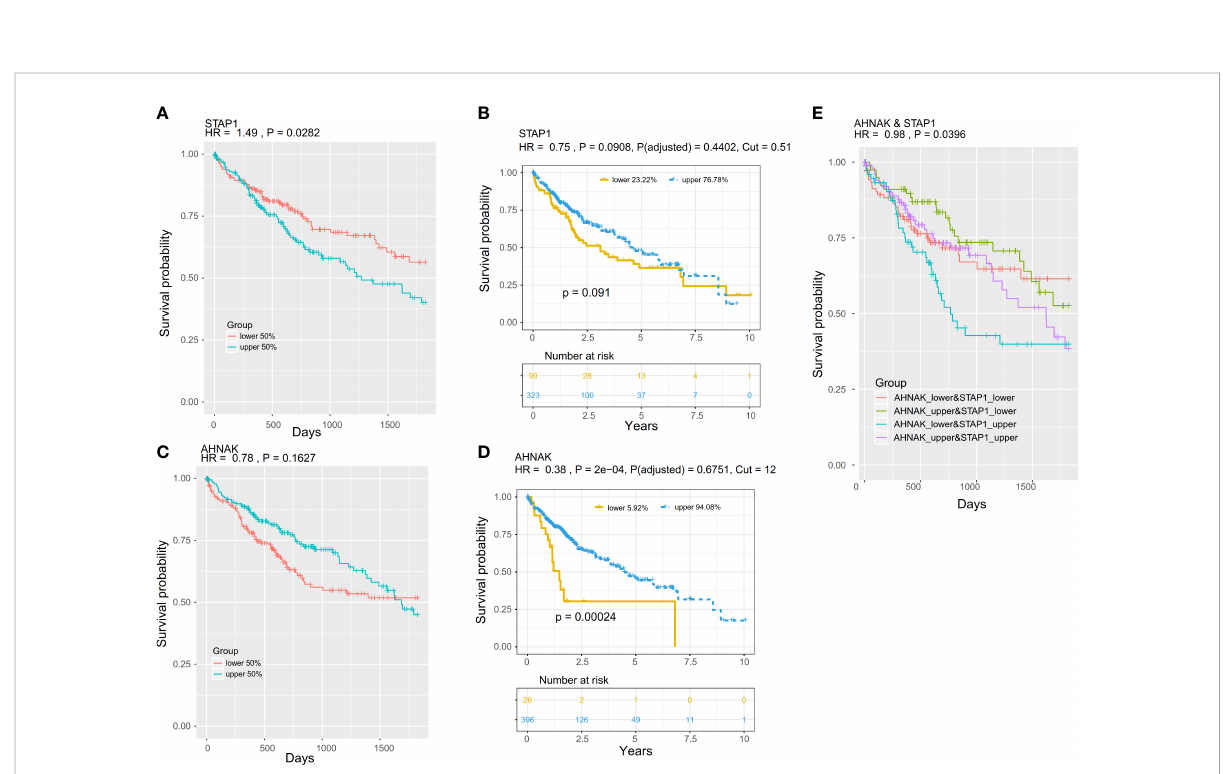
FIGURE 7 Prognostic value of the methylation and expression of AHNAK and STAP1 . The K – M survival curves show the overall survival of patients in The Cancer Genome Atlas project. The patients were strati fi ed (upper and lower) according to the median of the methylation or expression level. (A, B) K – M survival curves for STAP1 methylation (A) and expression (B) . (C, D) K – M survival curves for the AHNAK methylation (C) and expression (D) . K – M survival curves for the combination of methylation of AHNAK and STAP1 . (E) OS of different AHNAK &STAP1 combined